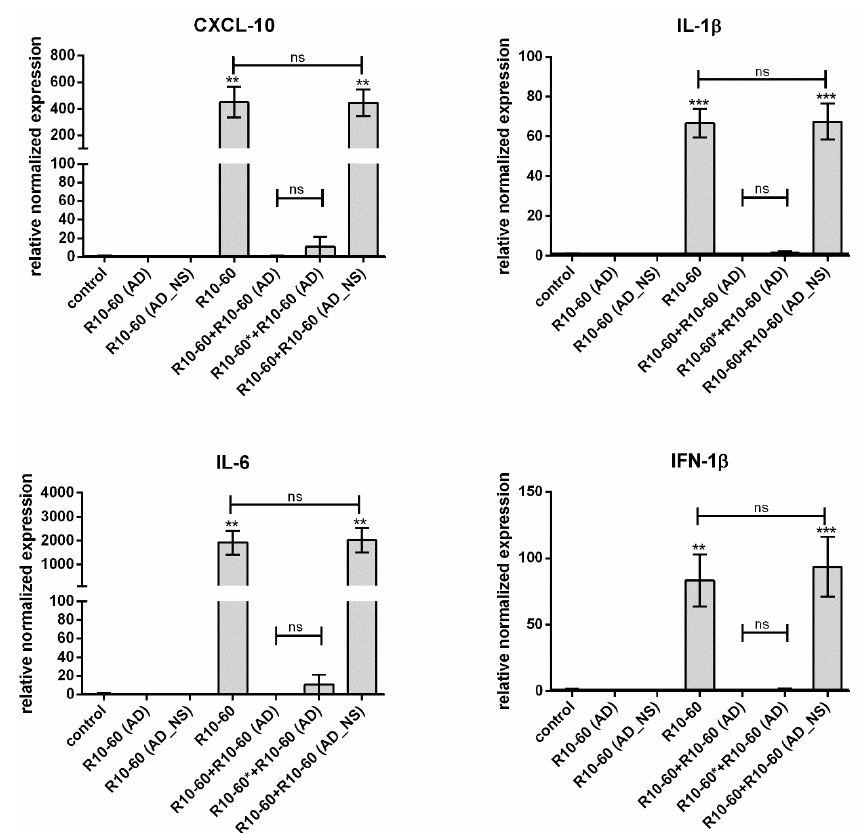
Figure 6. Blocking of R10-60 induced PMDC05 cell activation by adding of R10-60 (AD). IFN-1 β , CXCL-10, IL-1 β , and IL-6 expression in PMDC05 cells was determined using qRT-PCR analyses after incubation of cells for 4 h without or with R10-60 aptamer, R10-60 (AD), or R10-60 (AD_NS)